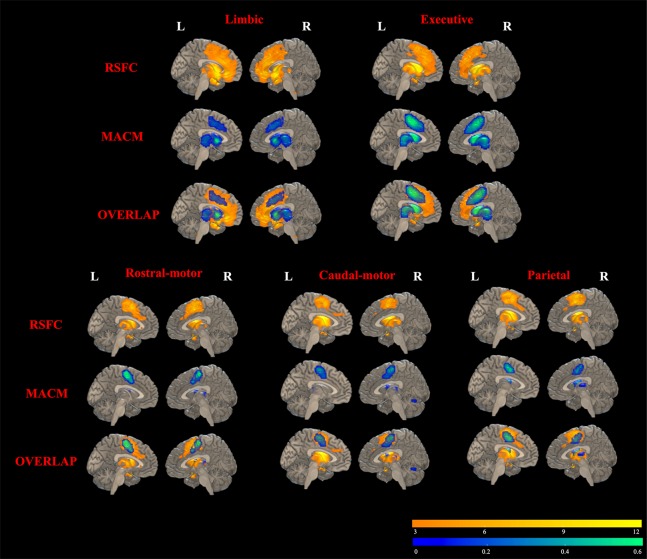
Overlapping results of task-dependent MACM and task-independent RSFC for the seven striatal subregions. Due to few/no significant connectivity results of occipital/temporal striatum subregion in MACM analysis at the current threshold, only functional connectivity modeling of five striatal subregions is presented. RSFC results are depicted in yellow in the top rows (FDR correction with a statistical threshold of p < 0.01). MACM results are displayed in blue in the middle rows (FDR correction with a statistical threshold of p < 0.01). Overlapped areas of yellow and blue in the bottom rows represent the consistent results of RSFC and MACM.